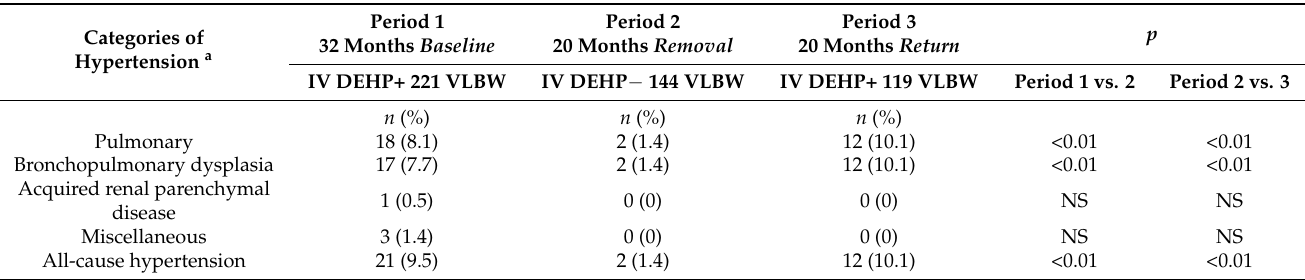
Table 2. Distribution of cases of hypertension in very low birthweight infants across periods of varying intravenous DEHP exposure.